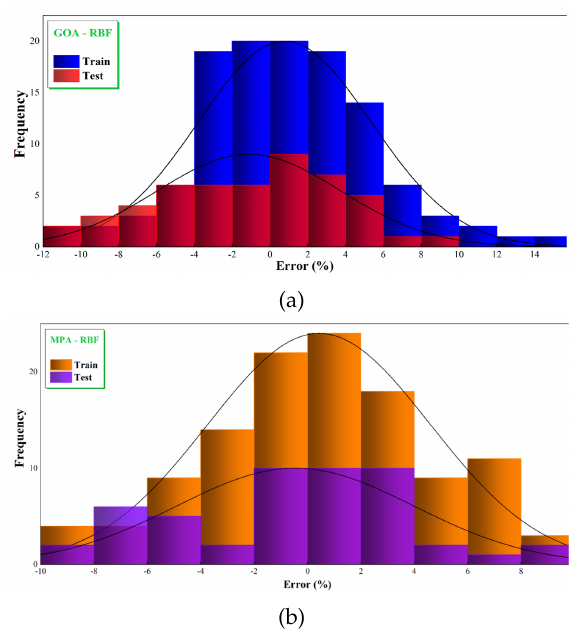
Fig. 7. Histogram of error percentage for proposed hybrid models